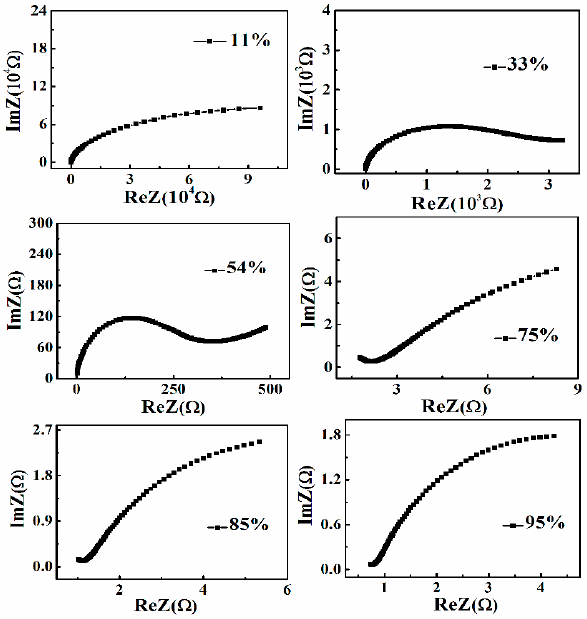
Figure 5. Complex impedance properties of the composite measured at different RH.